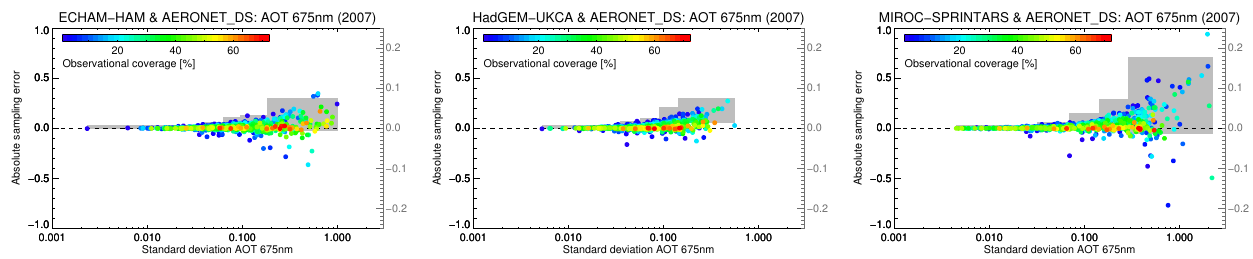
Figure 10. Absolute temporal sampling error for monthly mean AOT using AERONET sampling, as a function of time series standard deviation and observational coverage. The grey boxes in the background (axis on the right), show the 25 and 75% quantiles of those errors for equally sized sub-samples.